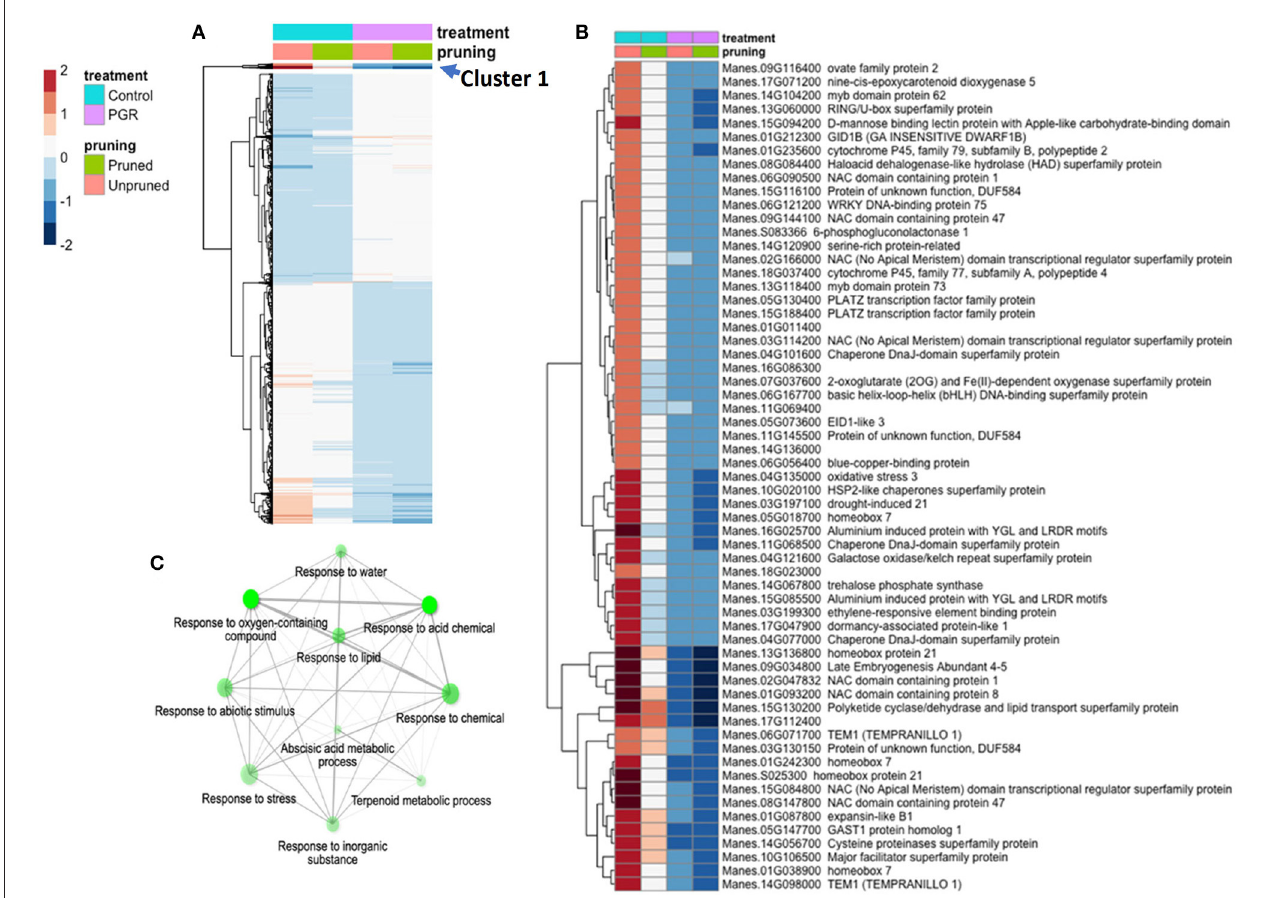
FIGURE 7 | DEGs in response to STS + BA PGRs and pruning. Colors indicate fold change (log 2 scale shown). (A) Full complement of 5,440 differentially expressed genes expressed (P adj ≤ 0.05) (averages of five biological replicates); (B) Uppermost slice (Cluster 1); (C) Enrichment analysis of the genes in Cluster 1. Color scale indicates log 2 fold changes. Legend in header indicates color coding of variables. STS, silver thiosulfate; BA, benzyladenine; PGR, plant growth regulator; DEG, differentially expressed